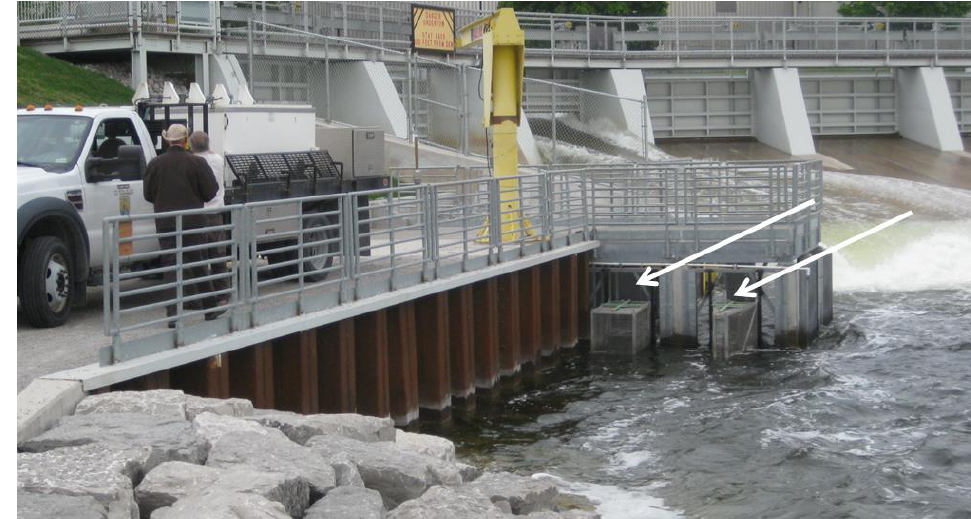
Figure 2. Photograph of the Cheboygan River dam, spillway (background) and trapping facility. Lamprey entered the traps from within a pre-trap bay jutting out into the river, which was made from metal grating and allowed lamprey to enter/exit from three sides. The STUD and adjacent funnel trap (arrows) were attached to the outside of the pre-trap bay and swapped daily. Water from the spillway, STUD ramp attraction flow, and gyre in the river produced a flow pattern within the pre-trap bay that shifted with river conditions.